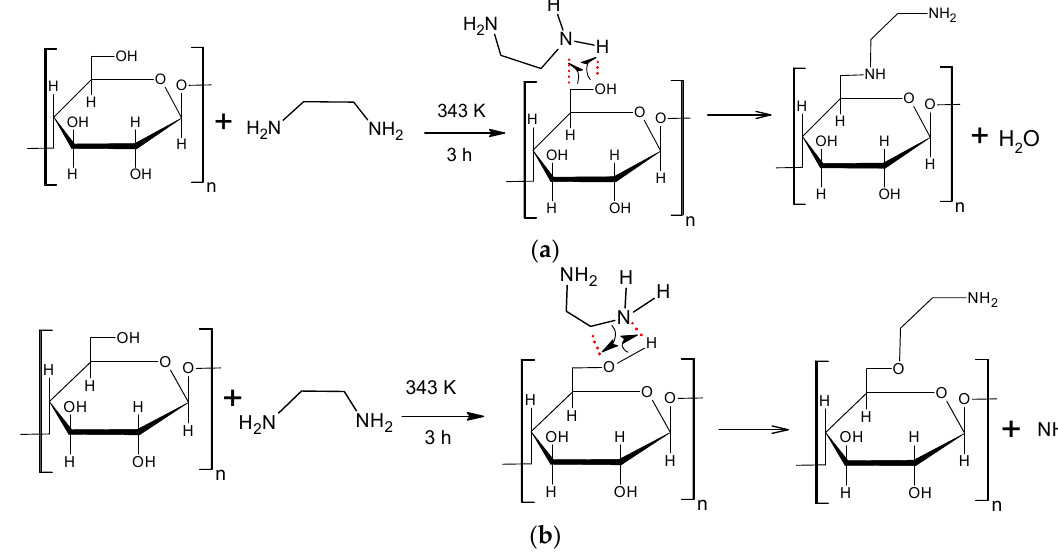
Scheme 1. Reaction mechanism proposed for the reaction between cellulose and ethylenediamine and the possible formed products.